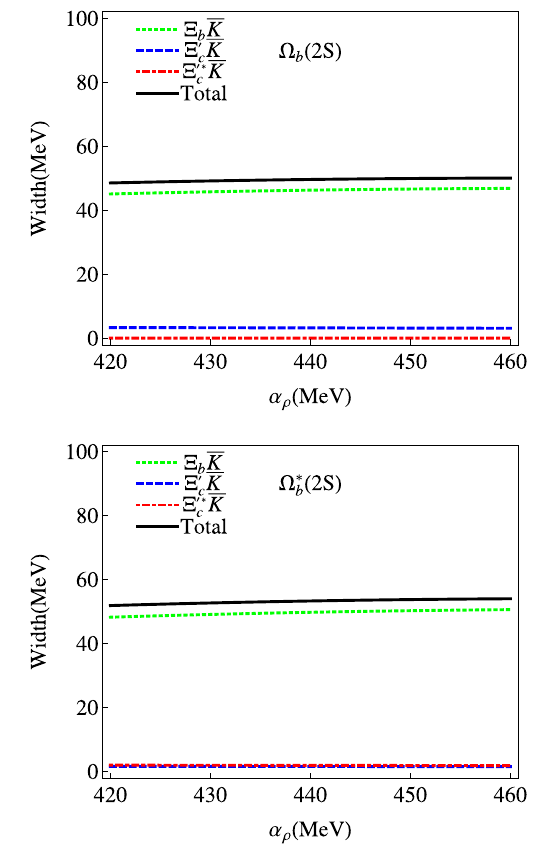
Fig. 6 The dependence of the decay widths on the harmonic oscillator parameter α ρ for the two (cid:2) b ( 2 S ) states